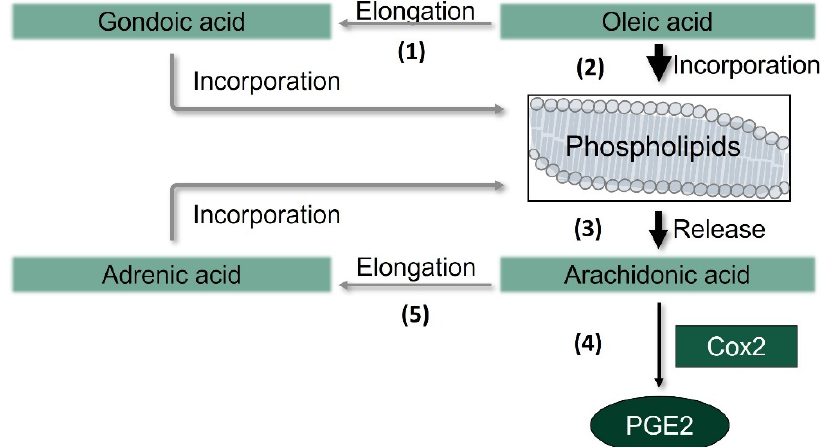
Figure 6. Potential mechanism of the elongation and incorporation of fatty acids in phospholipids and the formation of prostaglandin (PG) E 2 by cyclooxygenase (Cox) 2 after incubation with oleic acid in RAW264.7 macrophages. Oleic acid is elongated to gondoic acid ( 1 ) or directly incorporated into the phospholipids ( 2 ), leading to a net release of arachidonic acid (AA) ( 3 ), a substrate of Cox2. As substrate availability increases, AA can either be converted by Cox2 to prostanoids such as PGE 2 ( 4 ) or elongated to adrenic acid ( 5 ).